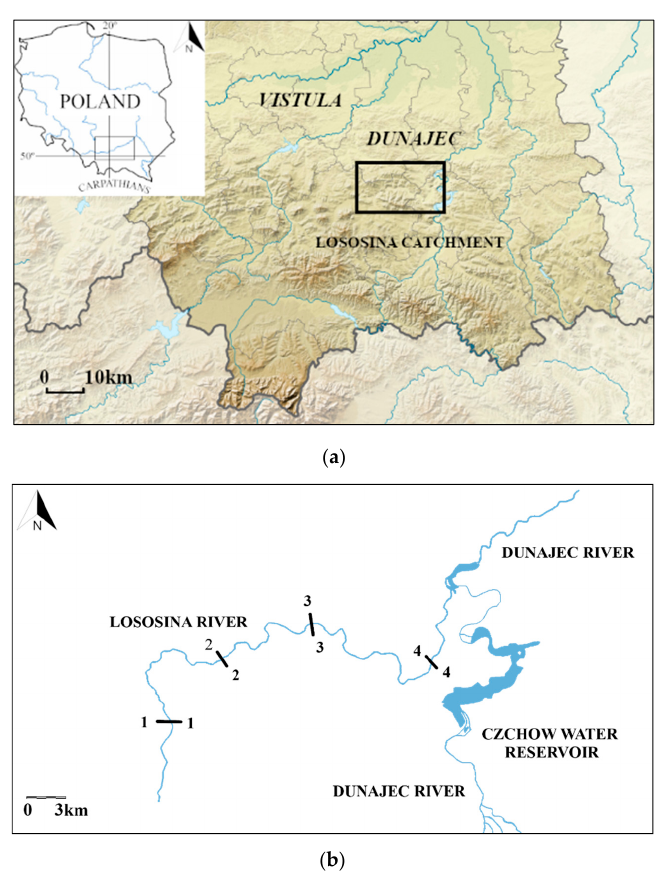
Figure 4. Catchment study region of the Lososina River ( a ) with a detailed sketch of the research reach ( b ).